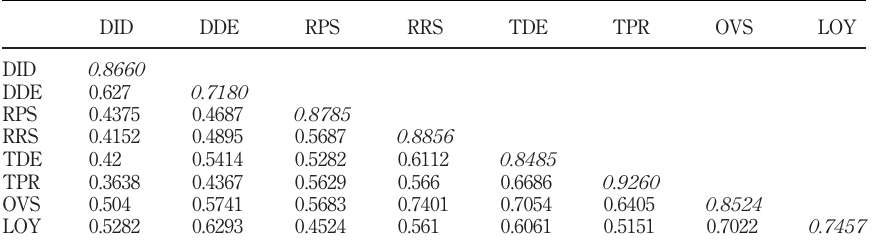
Table III. Discriminant validity